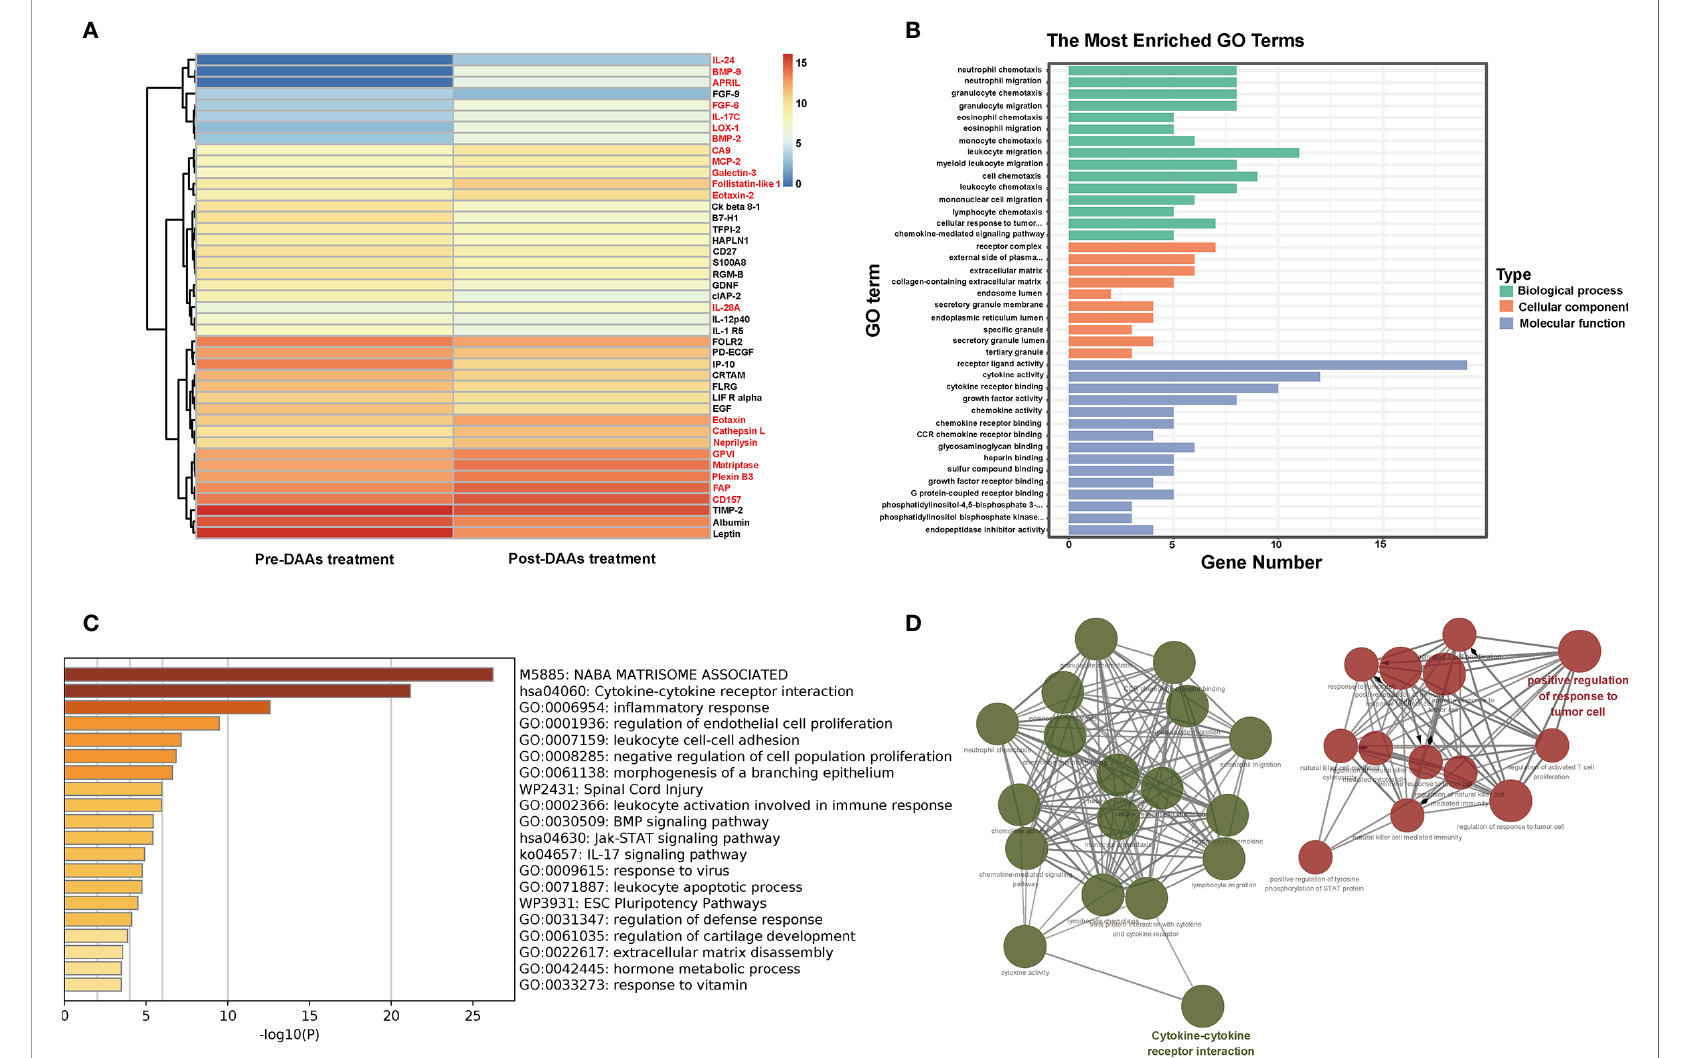
FIGURE 4 | Pathway analysis of 43 differentially expressed proteins in HPgV-2/HCV-coinfected patients between pre-DAAs treatment and post-DAA therapy. (A) Heatmap plots showing differentially expressed human cytokines, 21 upregulated cytokines labeled in red font while 22 downregulated cytokines labeled in black font. (B) The Gene Ontology enrichment analysis by “ clusterPro fi ler ” package in R software, the top 15 terms of biological process (BP), cellular component (CC), and molecular function (MF) are shown in bar chart. (C) The Gene Ontology processes enriched by Metascape platform and the top 20 terms are shown in bar chart. (D) The interaction networks of biological process using Cytoscape plug-in ClueGO show that the 43 differentially expressed cytokines mainly enriched in two function clusters including cytokine- cytokine receptor interaction and positive regulation of response to tumor